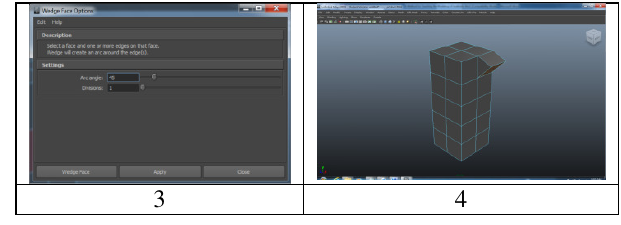
Figure 12. Wedge